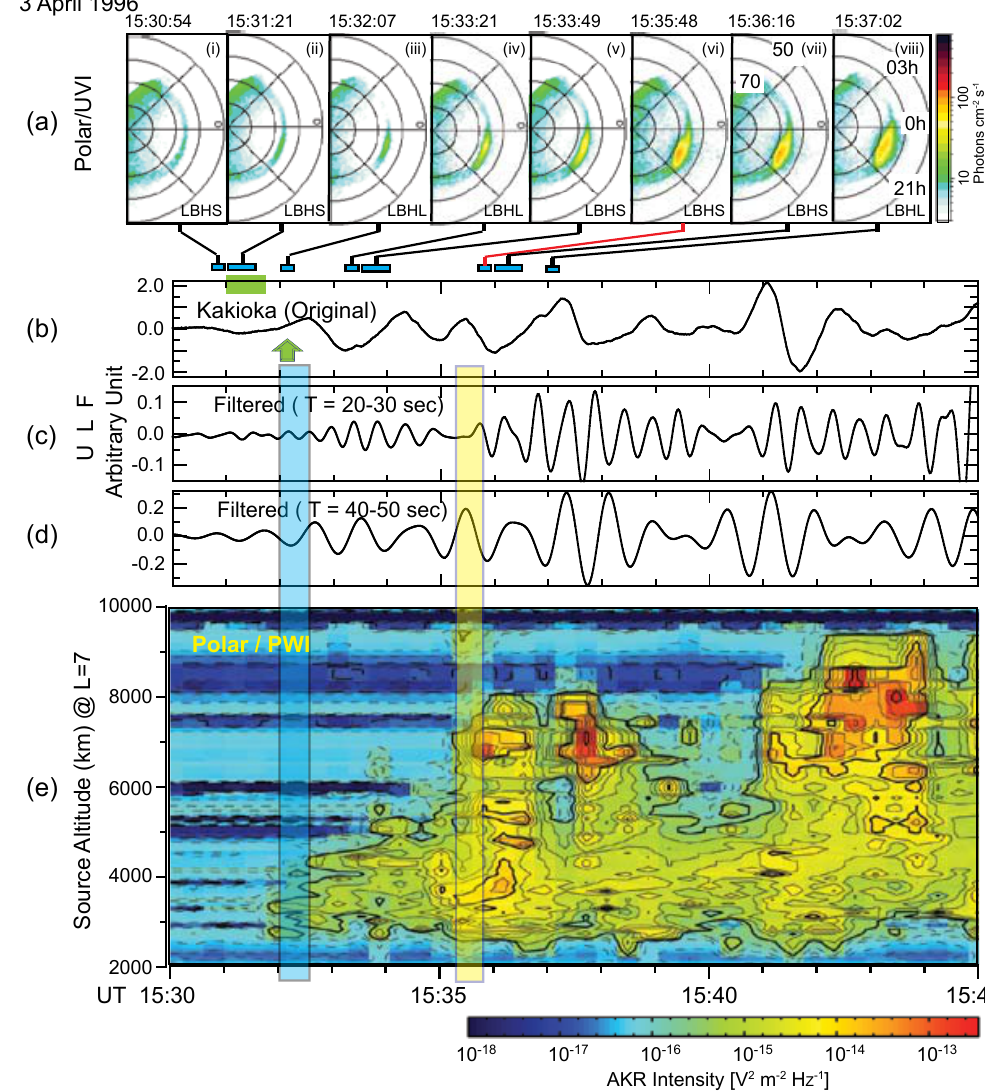
Fig. 5 Fig. 5. Relationship between global auroral activity, AKR development, and low-latitude Pi2 pulsation on 3 April 1996. (a) Polar/UVI images in dark hemisphere showing initial brightening around 15:31 (image (ii)) and breakup/poleward-expansion around 15:35UT (image (vi)). Small horizontal rectangles under images indicate exposure times. Green rectangle indicates “sudden brightening” defined by Liou et al. (1999). (b) dH/dt record from Kakioka; green arrow shows onset time of Pi2 pulsation defined by Liou et al. (1999). (c) and (d) Filtered components ( T =20–30 and 40–50s) of dH/dt data at Kakioka. (e) a − t diagram of AKR from Polar/PWI. Low-altitude AKR appeared around 15:32UT (blue vertical rectangle), and high-altitude AKR appeared around 15:35UT (beige vertical